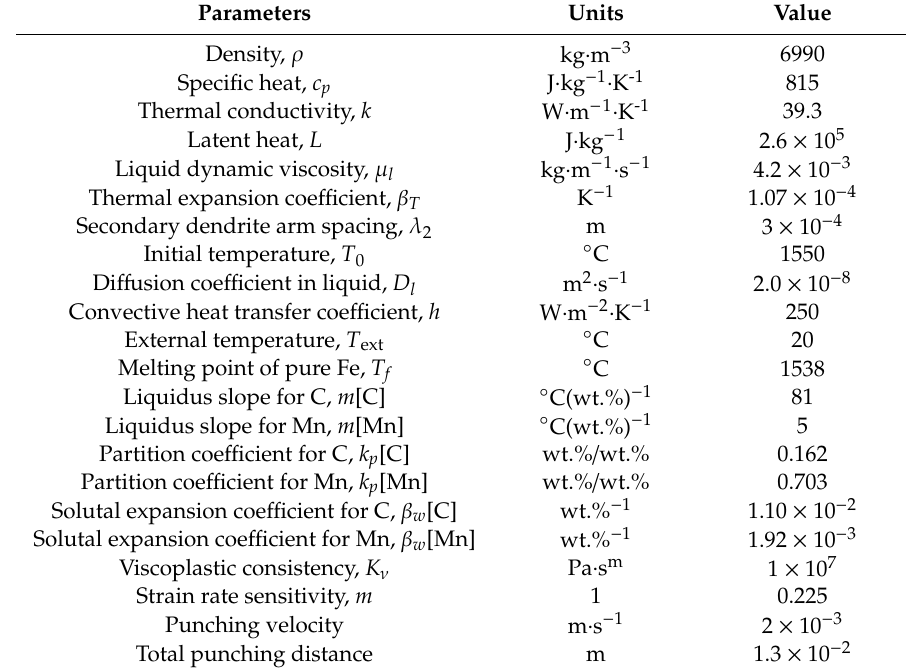
Table 1. Thermo-physical properties and computational parameters used in the simulation